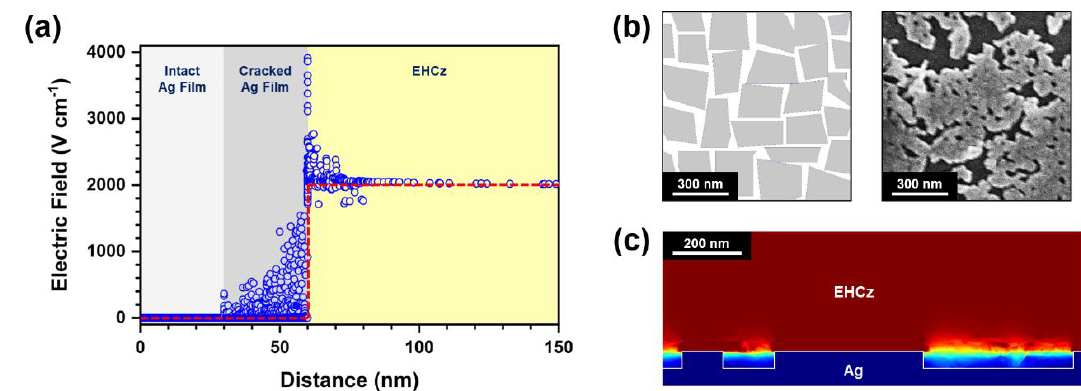
Figure 6. ( a ) Local electric field intensities according to the distance from the Ag bottom, based on the field intensity calculation at a fixed bias voltage of + 1.0 V. Blue circles indicate the local electric field intensities in the device with a highly cracked Ag structure (30-nm depth), and a red dashed line indicates the electric field in the reference device. ( b ) Model structure configured for the field intensity calculation in ( a ), and SEM image of BA140 used to prepare the model structure. ( c ) Local electric field intensities visualized for a selected cross section. The boundary between Ag and EHCz is indicated by a white line. The intensity level, presented by colors, increases from blue to red (i.e.,